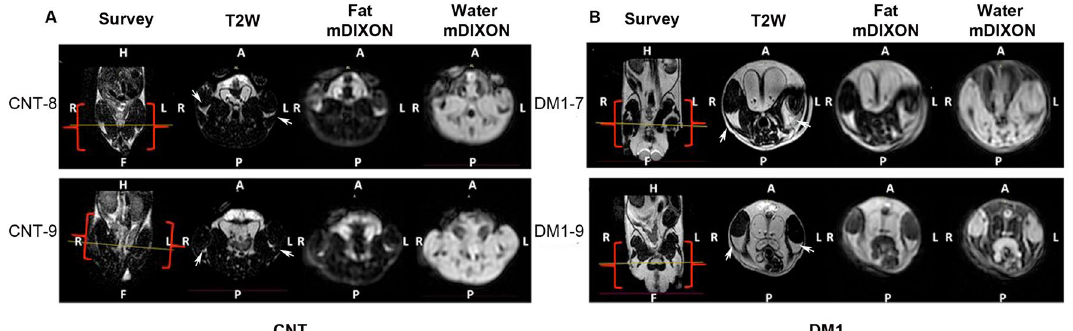
Figure 3. DM1 model mice show partial pathological phenotypes. Representative axial images from T2W, fat and water mDIXON of two control ( A ) and two DM1 model mice ( B ). The position is indicated on the coronal survey, and the red square brackets delimit the coverage of the acquired volume. H head, F foot, A anterior, P posterior, R right, L left. Arrows point to fat in the LC.